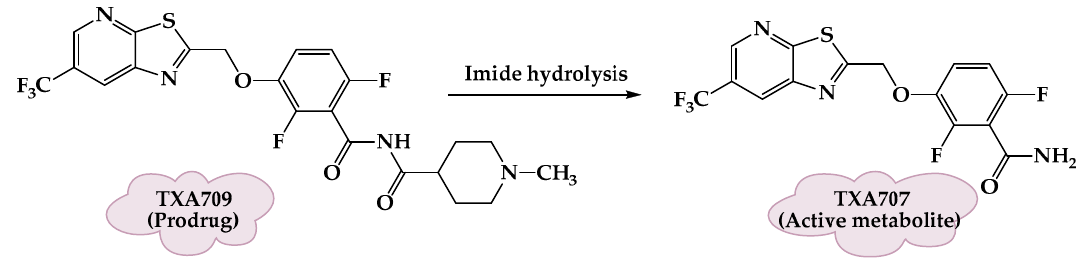
Figure 8. The activation of TXA709 prodrug to the active metabolite TXA707.